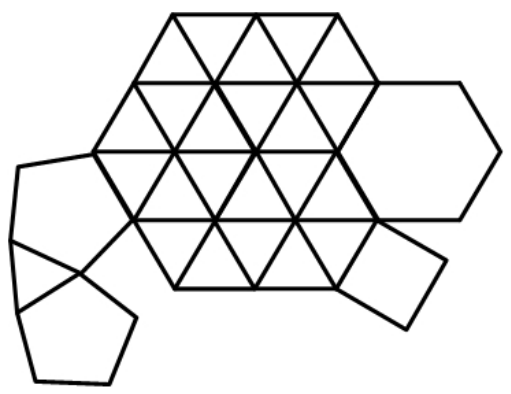
Figure 4. Quasi α - grid : multiple regular